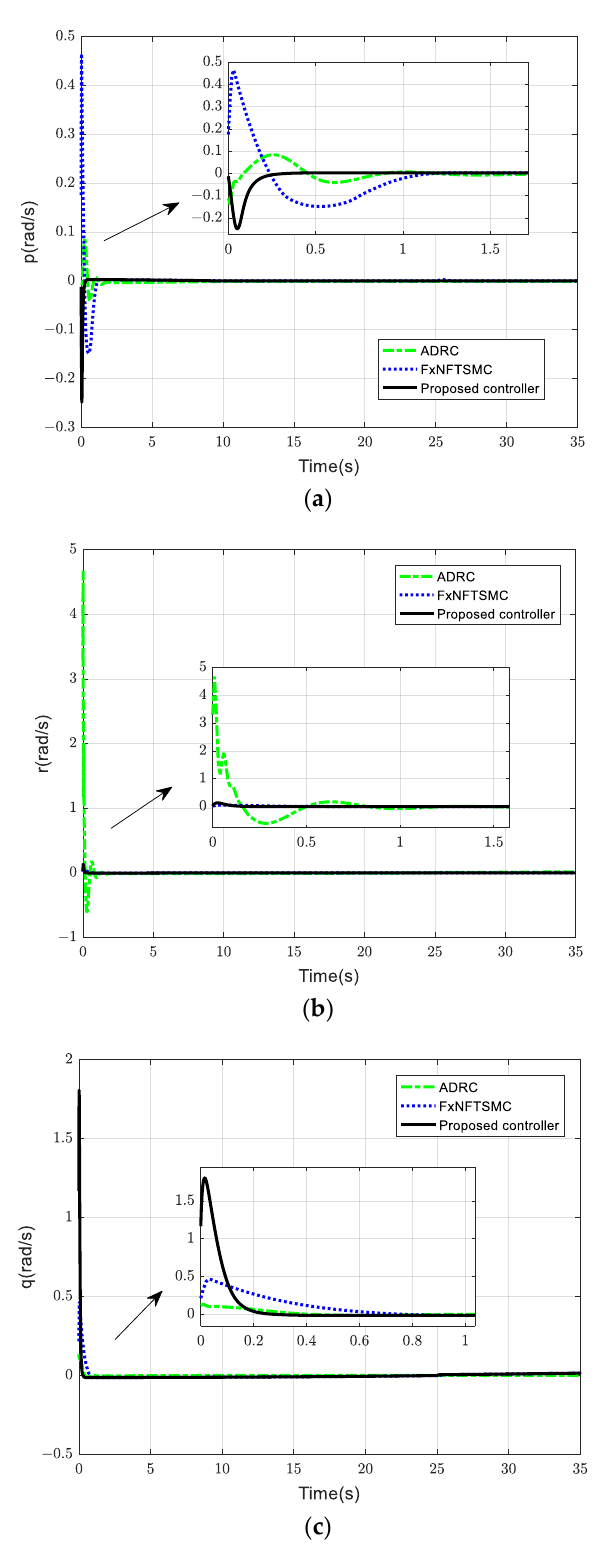
Figure 6. Time responses of angular velocity: ( a ) the roll channel; ( b ) the yaw channel; ( c ) the pitch channel.